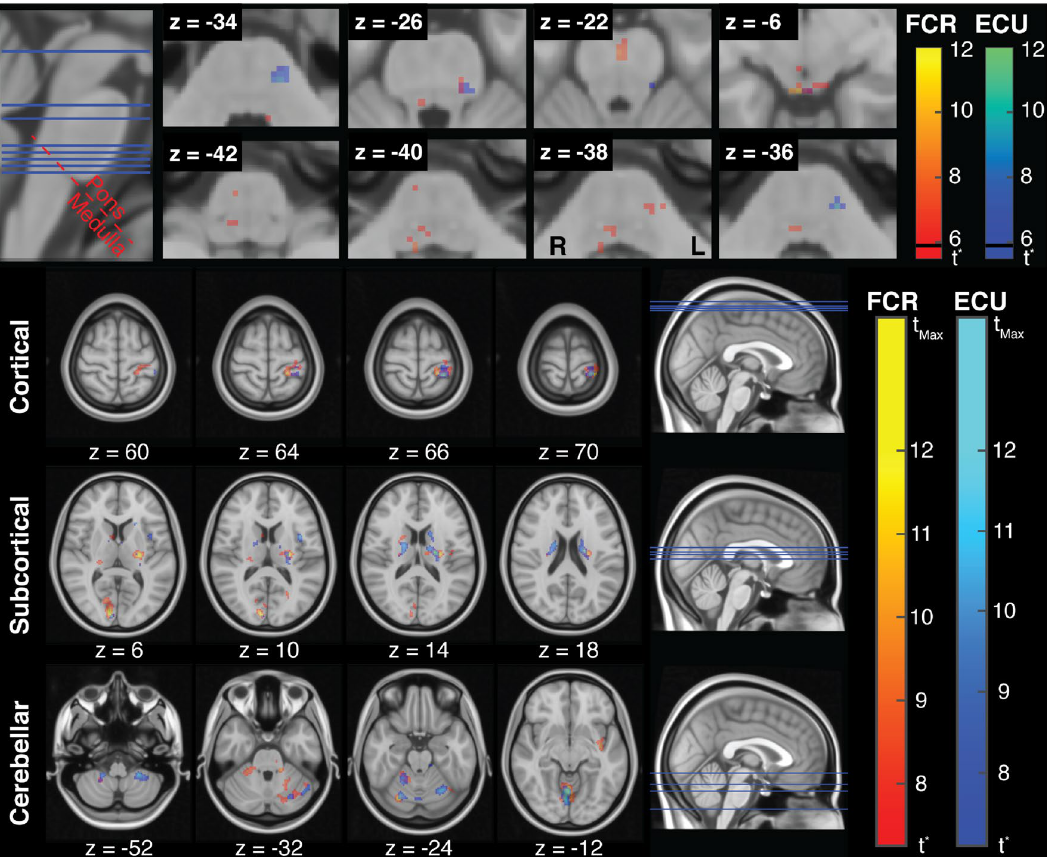
Figure 5. ( Top ) LLR-specific activation maps in the brainstem for FCR and ECU, with overlaid the plane of demarcation used to refer to voxels as being in the pons or in the medulla. The maps refer to contrasts β FCR > 0 and β ECU > 0 obtained for the brainstem-specific analysis. The threshold t -statistic, obtained after FWE correction, was equal 5.62 for both regressors. For reference, the t -statistic that refer to a Bonferroni correction ( t Bon = 5.8) is marked on each colorbar with a black line. ( Bottom ) LLR-specific activation maps in the whole- brain for FCR and ECU. The threshold t -statistic, obtained after FWE correction, was set to 7.25 and 7.09, respectively for FCR and ECU, while t Max was equal to 14.95 and 15.54, respectively. Colorbars are saturated at t = 12 for better visualization of t -statistic gradients. All statistical parametric maps are overlaid on axial slices of the standard Montreal Neurological Institute 152 template, with reported z coordinate in